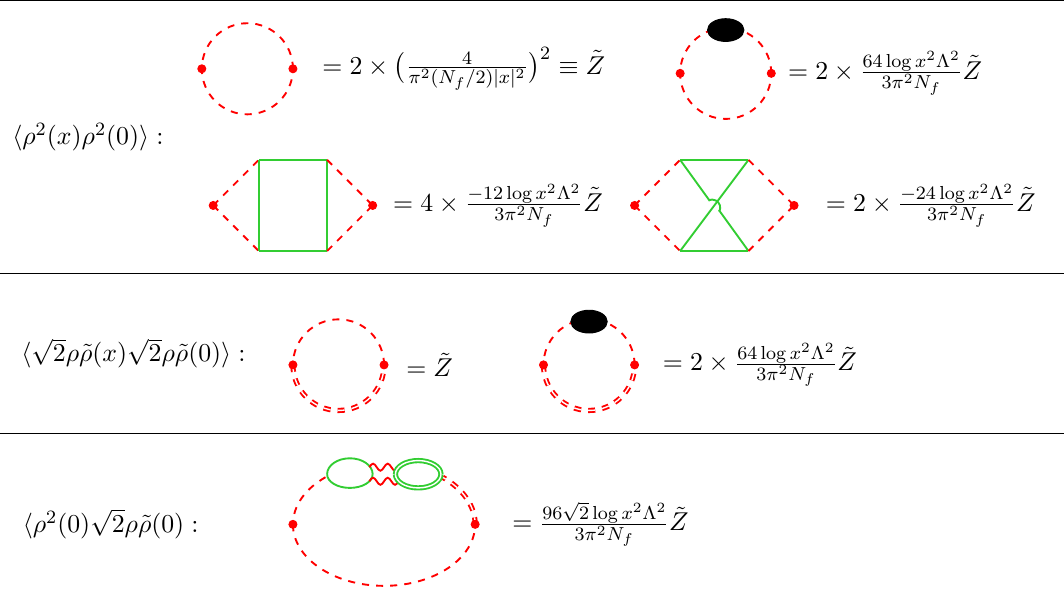
Figure 4 . Diagram responsible for mixing h (cid:26) ( x )~ (cid:26) (0) i .